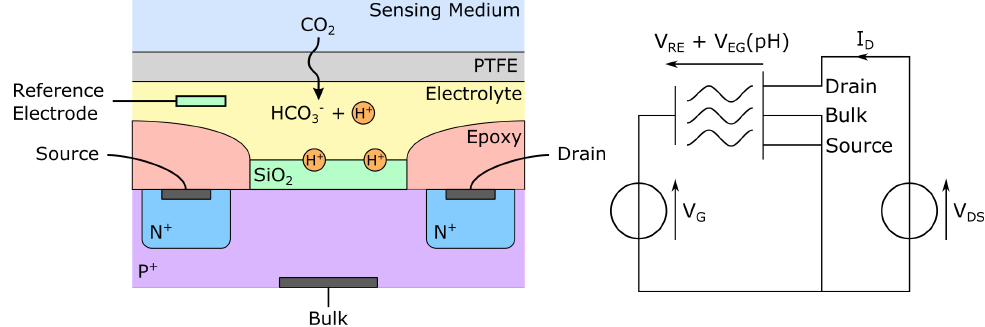
Figure 6. ( Left ) outline schematic of an ISFET CO 2 sensor. CO 2 diffuses from the analyte inside the inner electrolyte through a PTFE membrane, changing the pH of the electrolyte and generating hydronium ions (abbreviated H + ). The ions will penetrate the upper layer of the porous SiO 2 gate insulator, influencing the P + substrate underneath, and thus the conductance of the transistor. ( Right ) basic electrical implementation schematic of an ISFET sensor. The actual grid-source potential seen by the transistor is the sum of the applied grid voltage V G , the voltage between the reference electrode and the electrolyte V RE , and that between the electrolyte and the gate insulator V EG , itself function of the pH of the